Question: What does this figure show? Answer in one sentence.
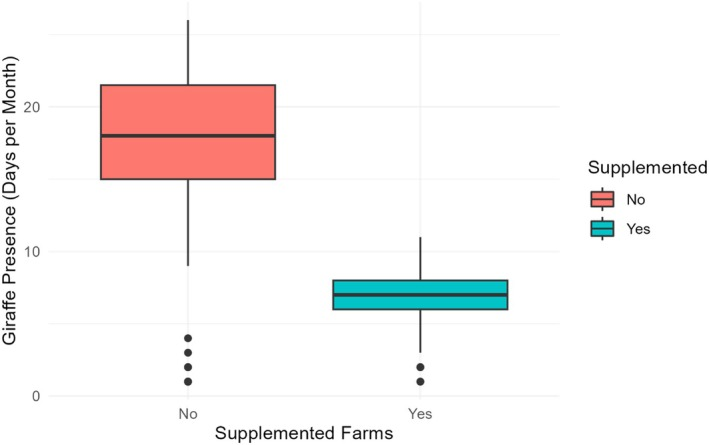
Answer: Giraffe presence in supplemented vs. non‐supplemented locations.